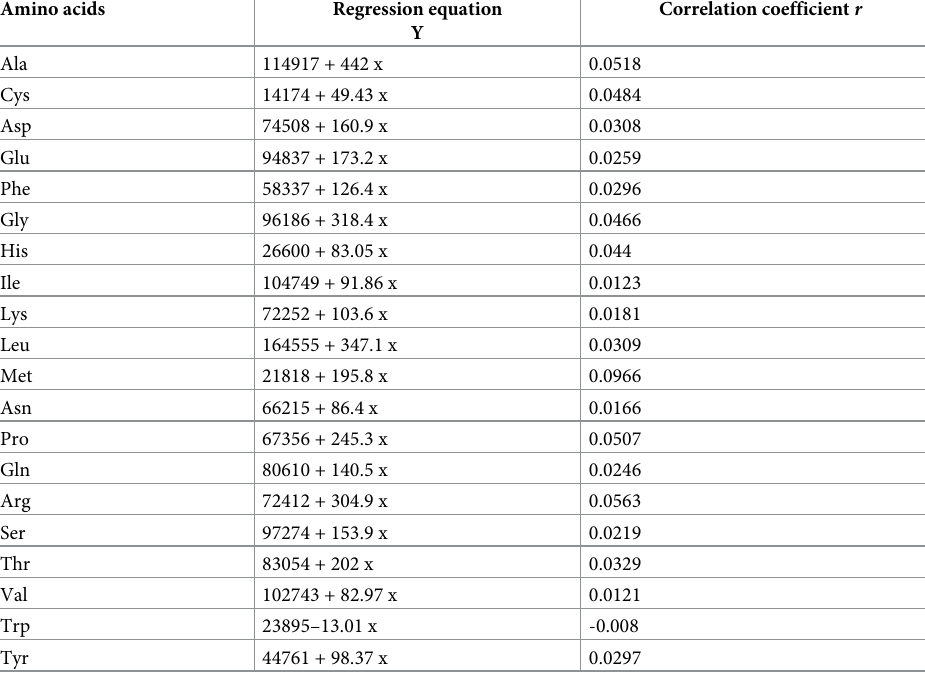
Table 2. Correlation analysis of GC% content and amino acid usage bias in cyanobacterial